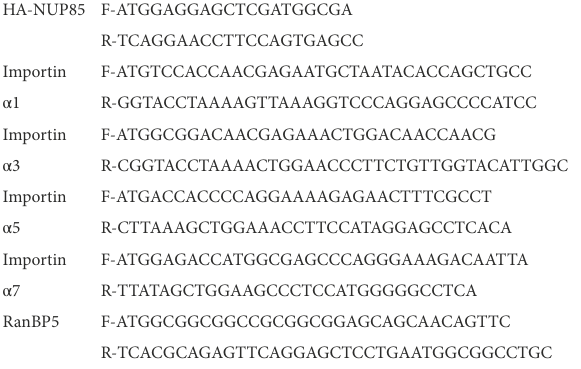
TABLE 2 List of sequences for siRNAs used in this study. siRNAs Sequence(5